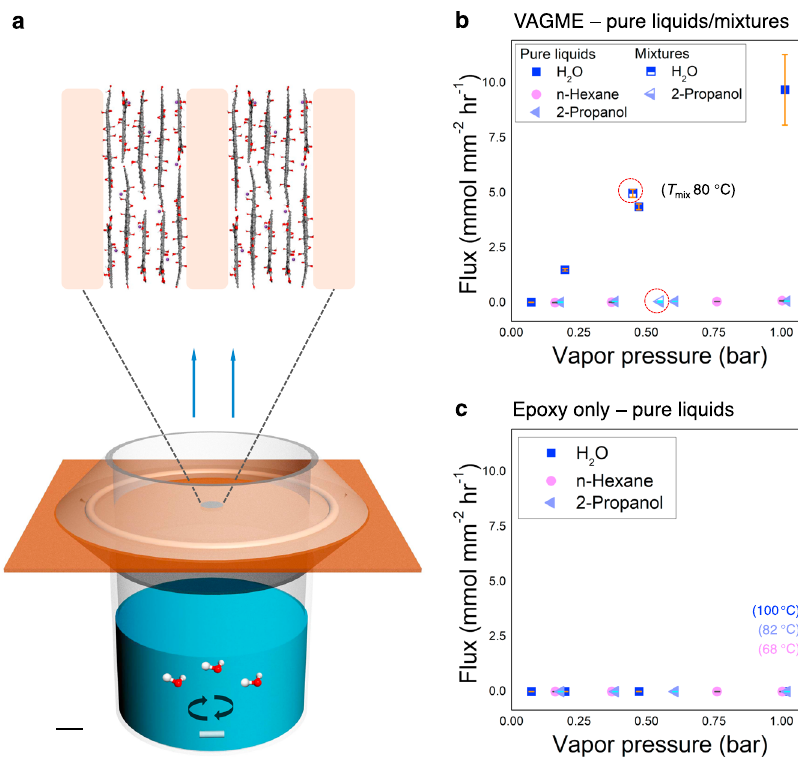
Fig. 3 Measurements of selective molecular transport through VAGME nanochannels. a Custom diffusion cell for temperature-dependent vapor permeation experiments. VAGME fi lms are adhered on the top of a copper sheet spanning a 4 mm diameter hole by epoxy adhesive, and the plate is clamped and sealed on top of a stirred liquid/vapor cell. Scale bar, 5 mm. b Measured vapor fl uxes through VAGME fi lms for pure liquids and liquid mixtures. Pure liquids: water, n-hexane and 2-propanol. Liquid mixtures (circled in red dot line): water and 2-propanol. c Control experiments for water, n- hexane or 2-propanol vapor permeation through epoxy-only membranes of same (20 μ m) thickness. Flux values are normalized by the active Zr-GO (nanochannel array) area. Table 1 Water vapor fl uxes measured through VAGME devices and conventional GO fi lms. Membrane